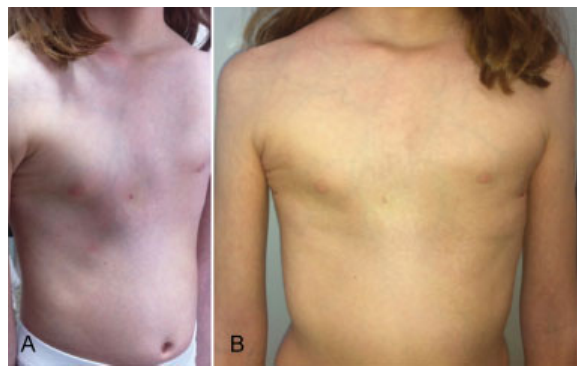
Fig. 4 Postoperative image of patient. ( A ) Postoperative oblique/ lateral view of patient ’ s chest. ( B ) Postoperative anteroposterior view of patient ’ s chest. A complete correction of the anterior chest wall deformity can be